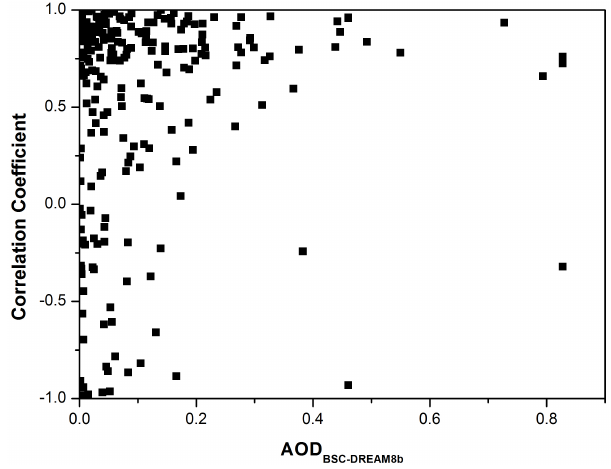
Figure 3. Linear correlation coefficient between PEARL and BSC- DREAM8b extinction profiles in the identified dust layer as a func- tion of the model aerosol optical depth (AOD) at